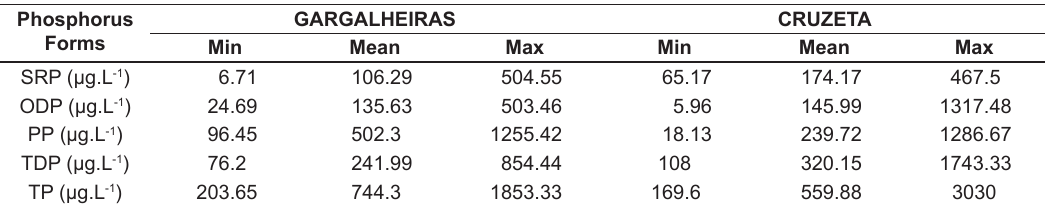
SRP= Soluble Reactive Phosphorus, ODP= Organic Dissolved Phosphorus, PP= Particulate Phosphorus, TDP = Total Dissolved Phosphorus, TP = Total Phosphorus.